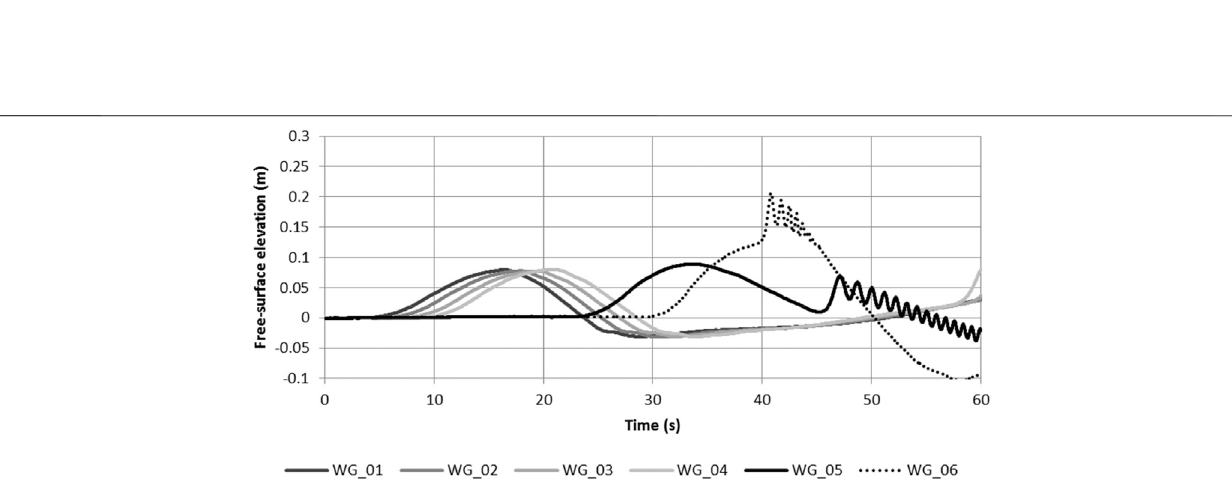
Frontiers in Built Environment |